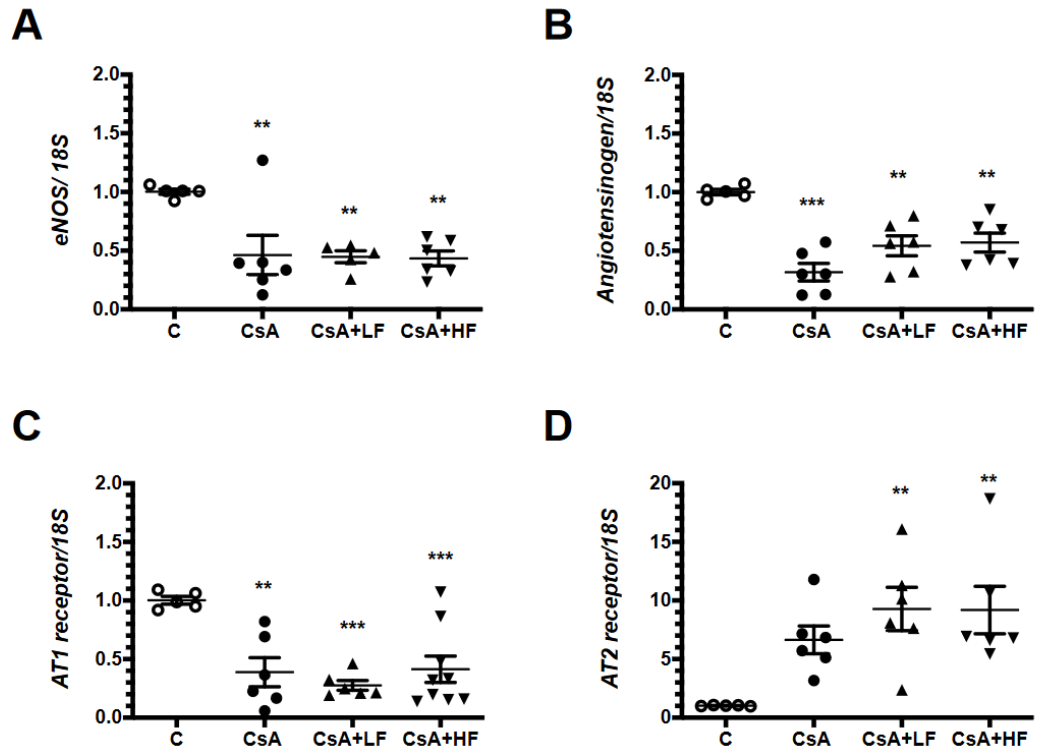
Figure 6. Effect of CsA and fosfomycin co-administration on vasoactive mediators. ( A ) eNOS , ( B ) angiotensinogen , ( C ) AT1R , and ( D ) AT2R mRNA levels in control (C, white circles), cyclosporine (CsA, black circles), CsA with a low dose of fosfomycin (CsA + LF, black triangles up), and CsA with high dose of fosfomycin treated rats (CsA + HF, black triangles down). n = 6. ** p < 0.01, and *** p < 0.01 vs. control group.